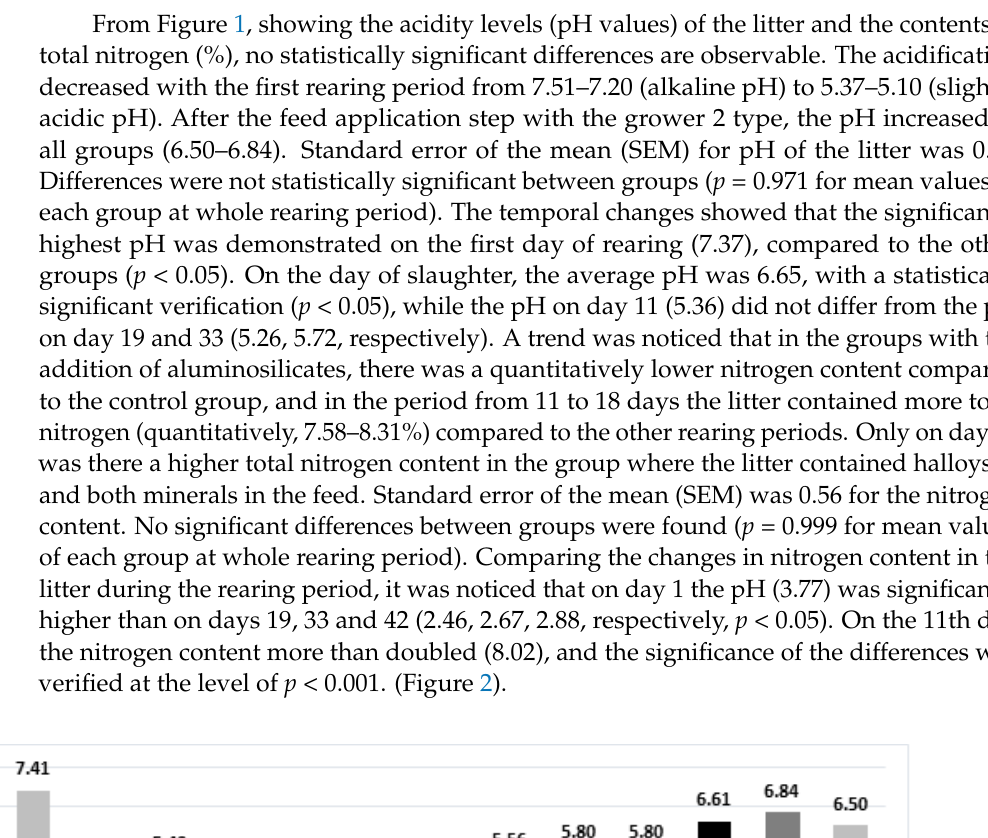
Figure 2. Total nitrogen (%) in the litter. Notes: 1—control group; 2—group with halloysite in the litter; 3—group with zeolite in the litter; 1st day—stater feed period; 11th day—grower 1 feed period; 19th day—grower 2 feed period; 33rd day—finisher feed period; 42nd day—slaughter day; sampling was performed once on the mentioned days. no significant